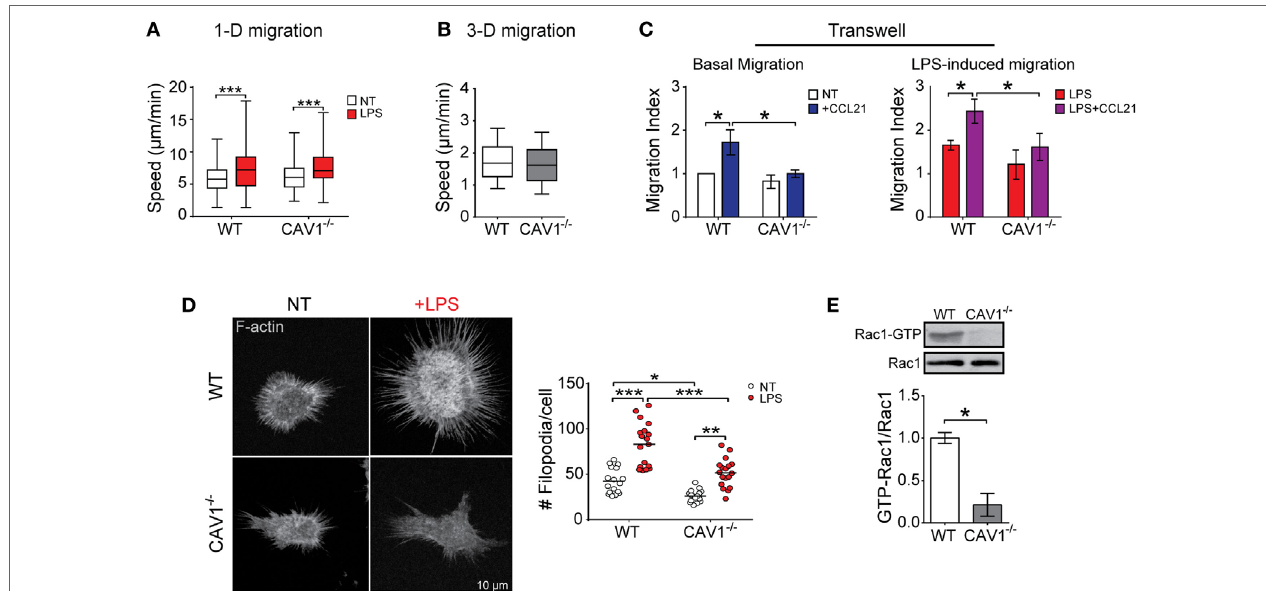
FigUre 3 | Caveolin-1 (CAV1) promotes dendritic cell (DC) transmigration, actin membrane protrusions, and Rac1 activation. Migration of wild-type (WT) or CAV1 − / − bone marrow-derived DCs (BM-DCs) in different in vitro assays. (a) BM-DCs treated or not with LPS (1 µg/ml, for 30 min) were individually tracked in confined microchannels (4 µm). After 5–6 h, cell images at different positions along the channels were recorded during 10–12 h (one photo each 2 min) using an automated microscope. The reconstructed movie is analyzed, and the average speed of every cell obtained. In the box plots, the bars include 90% of the data points, the center corresponds to the median, and the box contains 75% of the data points. Data from two different experiments, n = WT: 221, WT + LPS: 153, CAV1 − / − : 120, CAV1 − / − + LPS: 236 cells (*** p < 0.001). (B) Chemotactic migration of LPS-treated WT or CAV1 − / − BM-DCs embedded in a 1% bovine collagen gel containing a CCL21 gradient. Mean velocity of LPS-DCs depicted as a function of the distance to the CCL21 source. In the box plots, the bars include 90% of the data points, the center corresponds to the median, and the box contains 75% of the data points. n = WT: 1,090, CAV1 − / − : 1,169 tracks, from two independent experiments. (c) DC transwell migration. The bottom side of transwell membranes was coated with fibronectin to avoid losing migratory cell. In the bottom chamber, RPMI medium containing 0.5% fetal bovine serum with or without CCL21 (20 ng/ml) was added. Then, 2 × 10 5 of WT or CAV1 − / − BM-DCs were seeded in the upper chamber, and migration was evaluated by counting cells on the bottom surface of the membrane. Left panel, immature BM-DC migration after 1 h. Right panel, LPS-matured BM-DC migration after 30 min. The migration index (relative to spontaneous WT DC migration) is shown. Bars are mean ± SEM (* p < 0.05, n = 3). (D) In the left panel, representative confocal microscopy images showing F-actin (phalloidin staining) in WT or CAV1 − / − BM-DCs treated or not with LPS (100 ng/ml, 24 h). To the right, the quantification of protrusions per cell is shown. Each dot corresponds to one cell, and the black bar represents the mean (* p < 0.05, ** p < 0.01, and *** p < 0.001, n = 18 cells, two experiments). (e) GTP-Rac1 levels were determined in WT and CAV1 − / − DCs using pull-down assay followed by Western blot. Representative blots showing the active GTP-bound fraction and total Rac1. The ratio between active and total Rac1 is shown in the plot (densitometry analysis). Data are the mean ± SD (* p < 0.05, n =